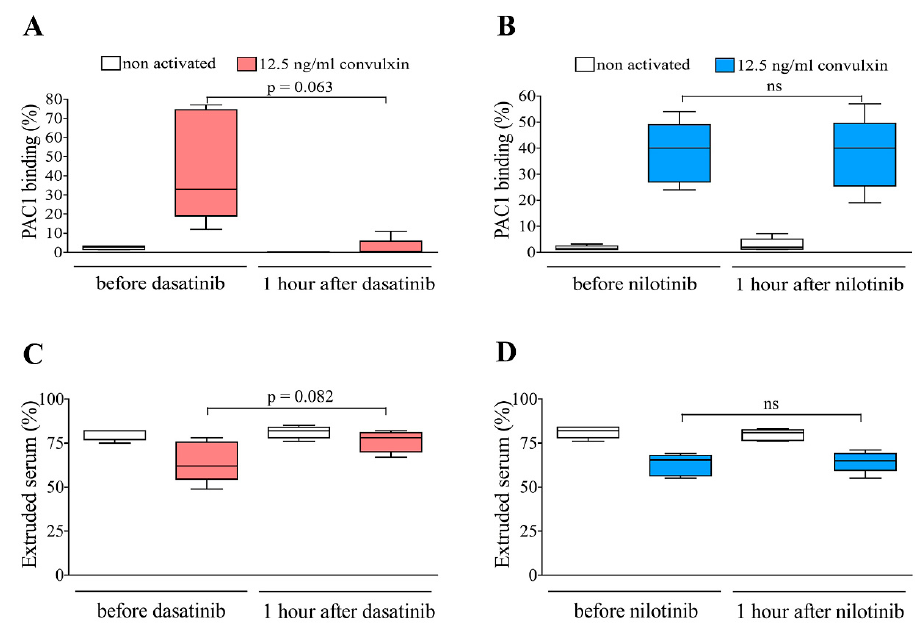
Figure 5. Integrin α IIb β 3 activation and clot retraction in PRPs of TKI treated CML patients. Blood was collected from dasatinib ( n = 5) or nilotinib ( n = 5) treated CML patients before and at 1 h after witnessed drug administration. Platelets of patients were stimulated with convulxin in PRP. The percent of active conformation of integrin α IIb β 3 is shown by FITC-PAC1 binding in the cases of dasatinib or nilotinib treated patients respectively (Panels A and B ). Panels C and D show results of clot retraction in PRPs of dasatinib or nilotinib treated patients.